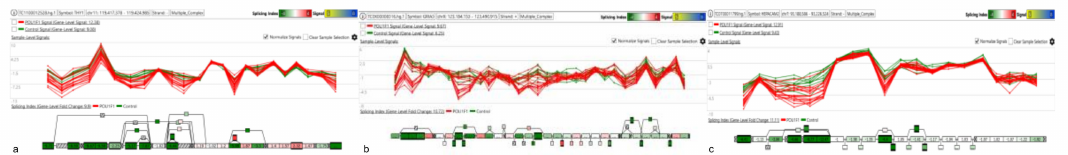
Figure 7. Panels ( a – c ) depict the splicing events in THY1 , GRIA3 and HEPACAM2 genes characterizing POU1F1.